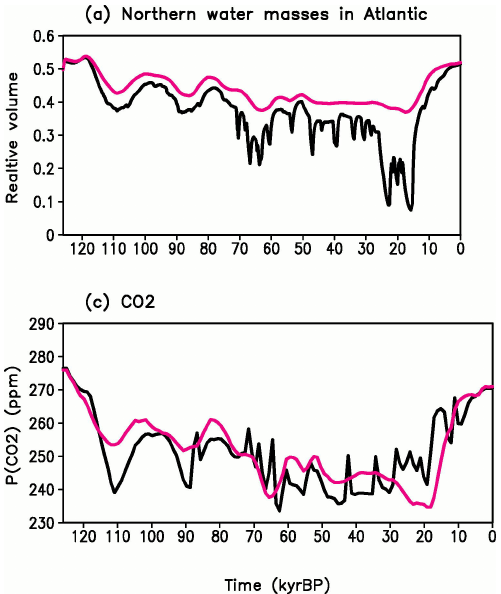
Fig. 8. Relative volume of the water masses of the northern origin in the Atlantic ocean (a) and simulated atmospheric CO 2 concentra- tion (b) . Black line – experiment P , pink line – experiment P